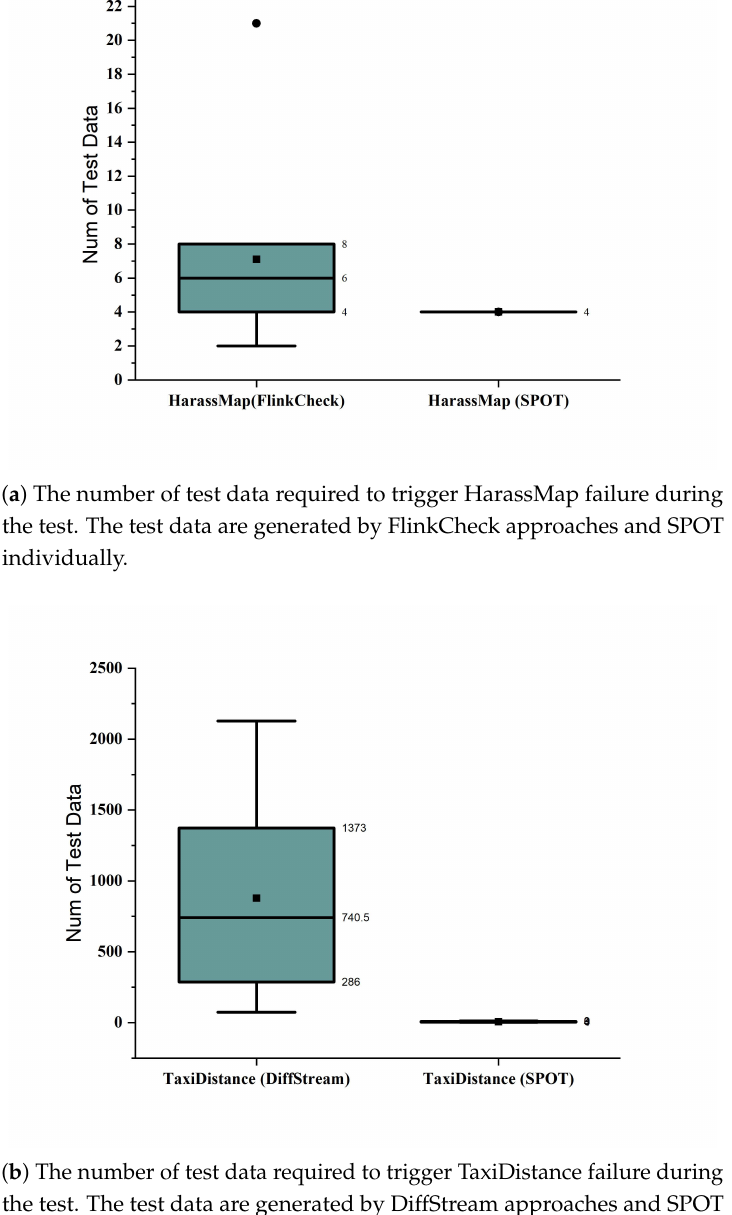
Figure 9. Results of the number of test data to trigger software